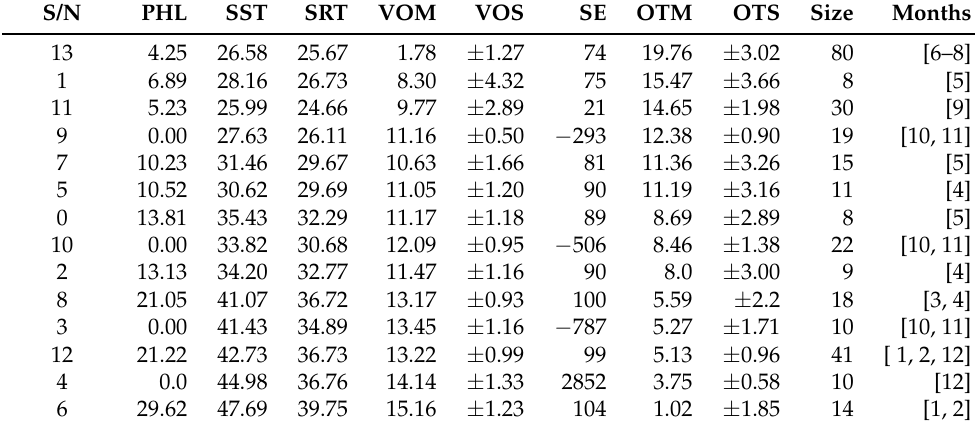
Table 11. Closed patterns from global model showing correlations between all three views after receiving chunk